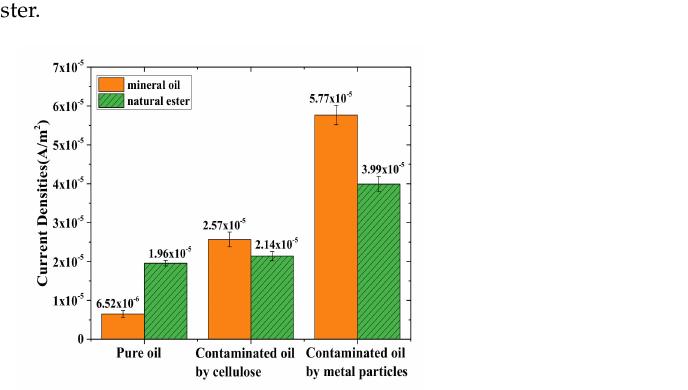
Figure 7. Current density of oil containing particles under DC electric field (11.25 kV, 7.5 mm).